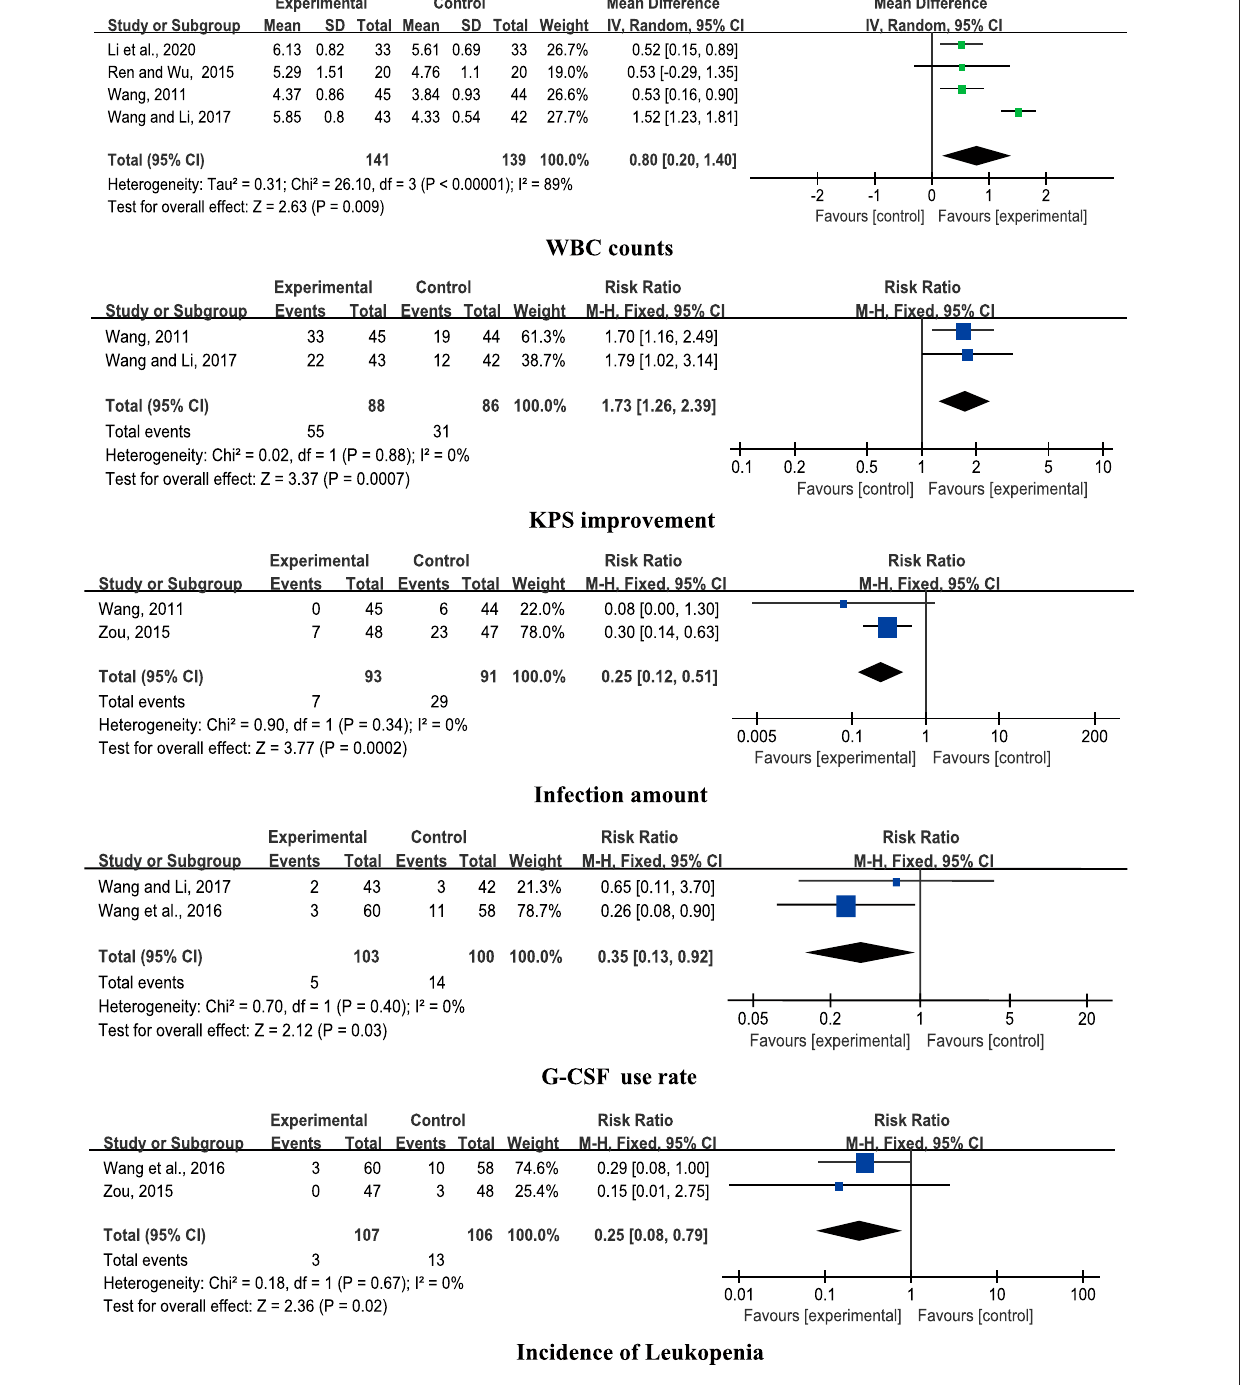
FIGURE 4 | Forest plots of CHM + chemotherapy vs. WM + chemotherapy.